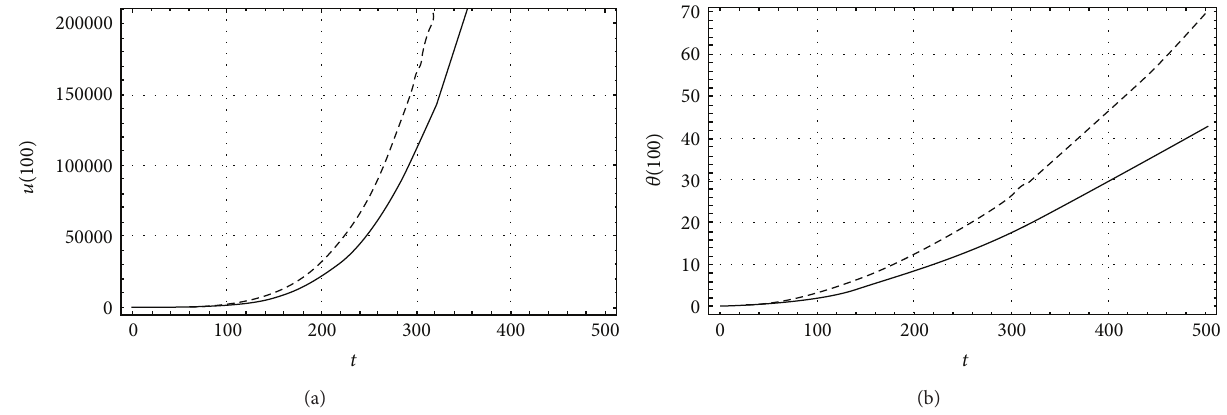
Figure 15: The displacement as a function of time and the temperature for two values of 𝛽 1 (GL) at 𝑥 = 100 , 𝑎 = 0.5 , 𝐴 = 0.001 , 𝑏 = 0.5 , = 0.05 , 𝛾 = 1 , 𝛿 = 0.8 , Ω = 0.1 , 𝜎 𝛼 = 1 , 𝛽 2